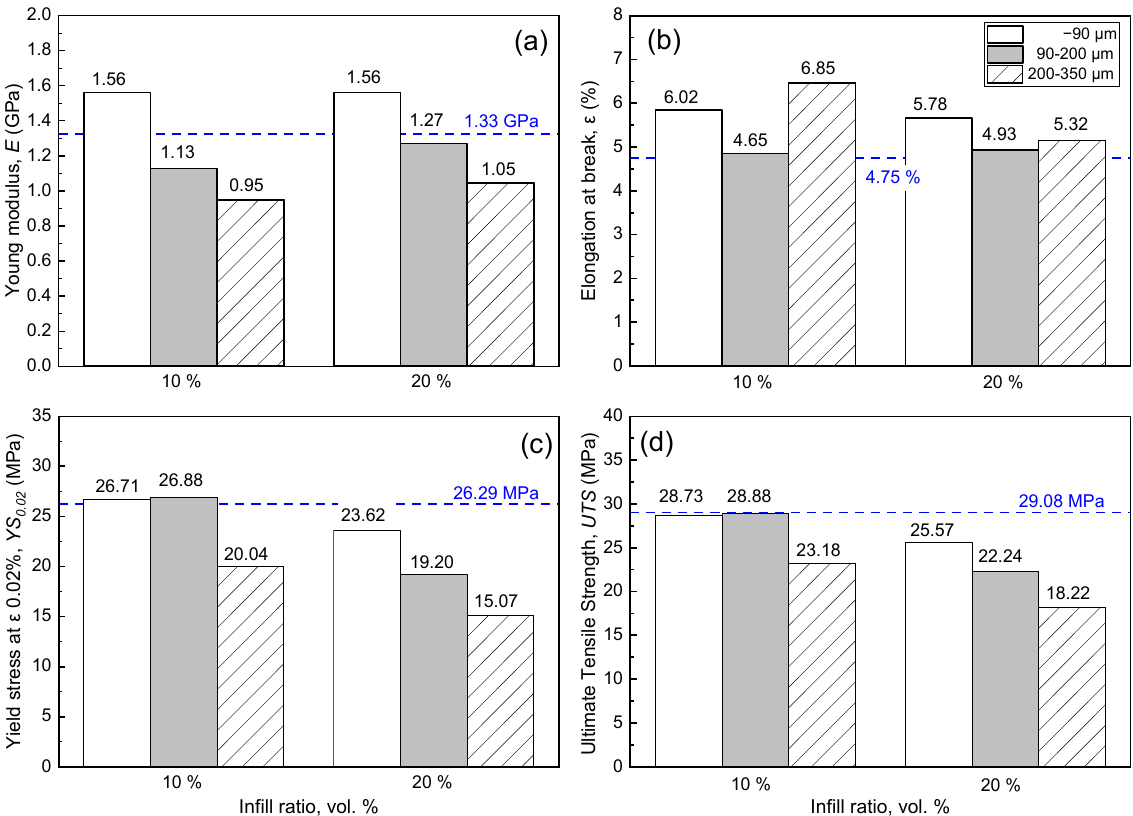
Infill ratio, vol. % Figure 12. Mechanical properties of FDM dogbones printed using filament with different filler content and filler granulometry: ( a ) Young modulus, ( b ) elongation at break, ( c ) yield stress at elongation of 0.02%, and ( d ) ultimate tensile stress. Dashed horizontal lines depict relevant value for FDM dogbone made solely of ABS.